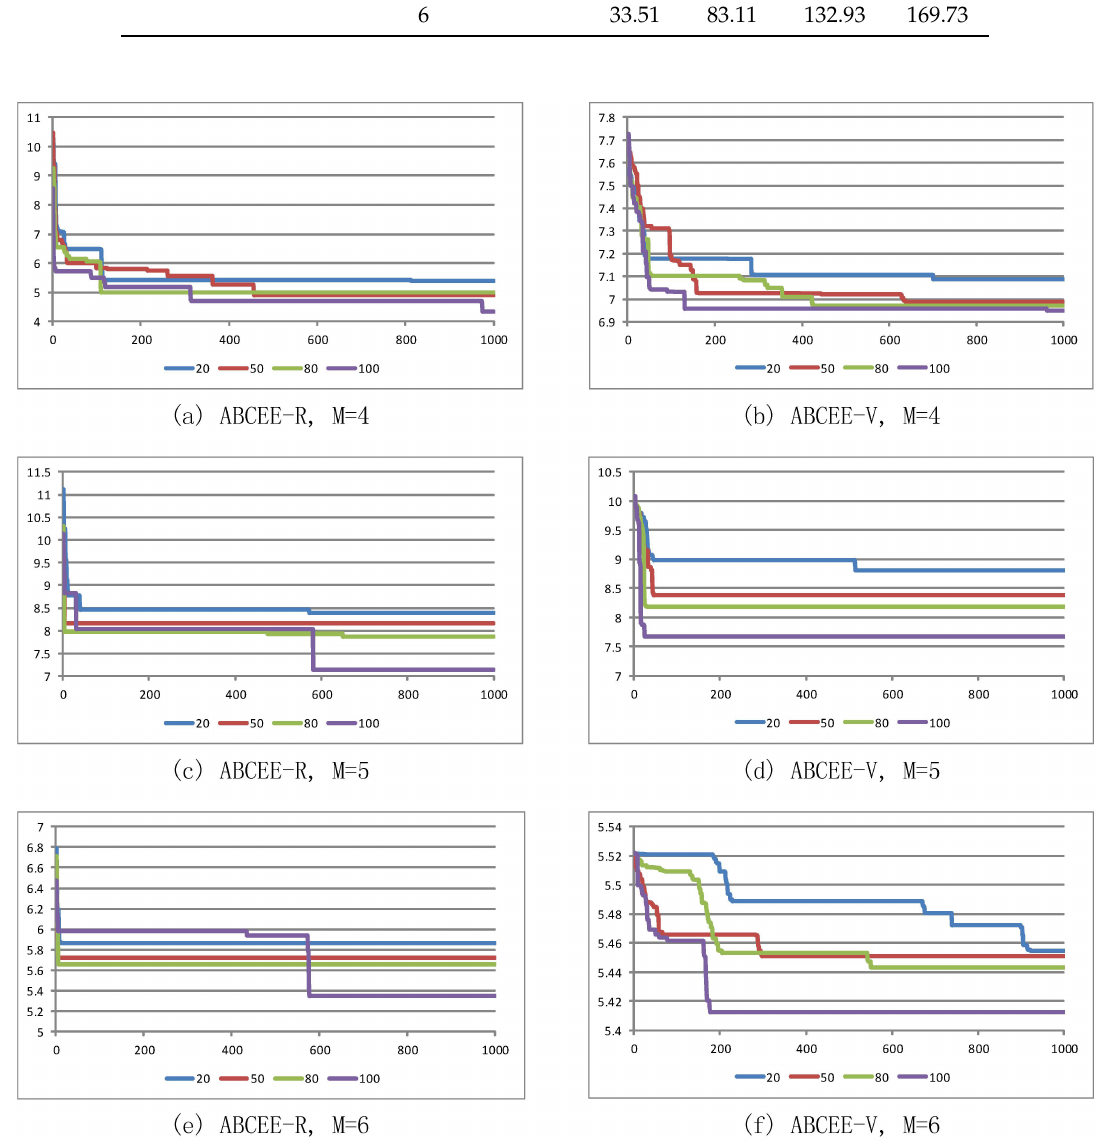
Figure 3. Changes in the ABCEE objective function over the course of multiple iterations. The horizontal axis represents the iteration number, and the vertical axis represents the logarithm of the objective function value. ( a ) ABCEE-R, M=4; ( b ) ABCEE-V, M=4; ( c ) ABCEE-R, M=5; ( d ) ABCEE-V, M=5; ( e ) ABCEE-R, M=6; ( f ) ABCEE-V,